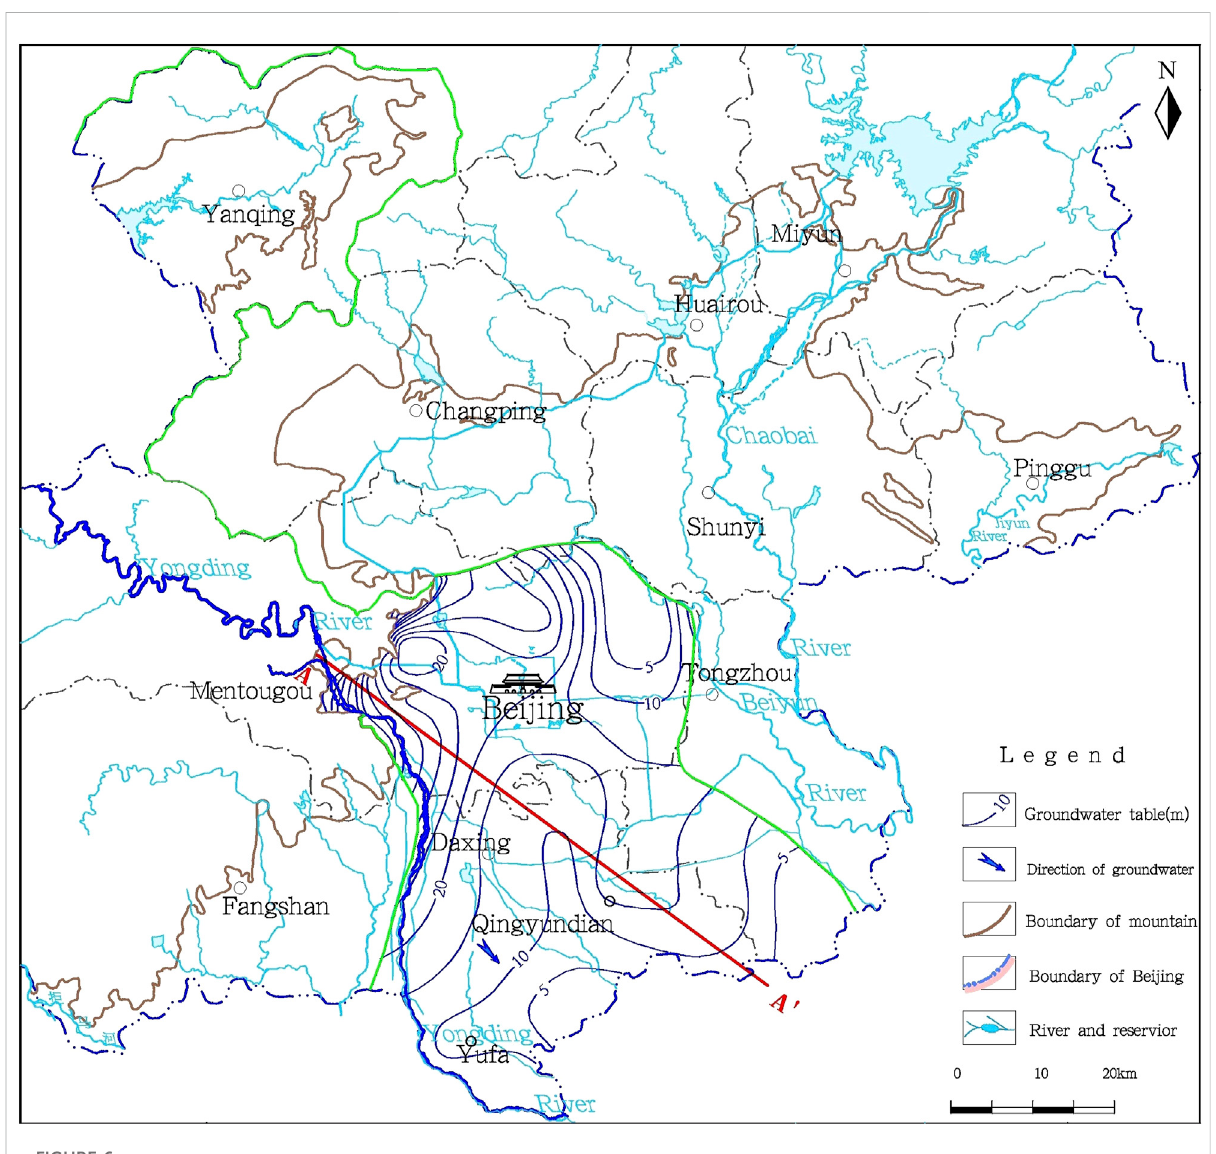
FIGURE 6 Contour map of the pore phreatic water level in